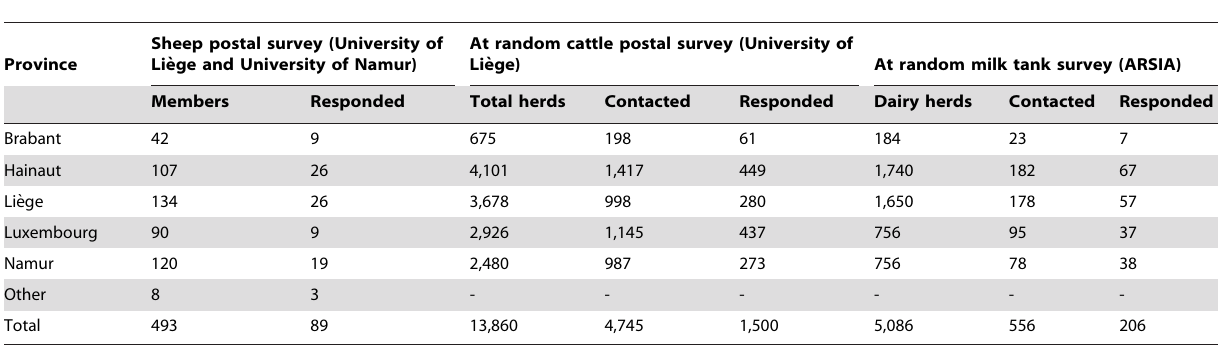
Table 1. Design of the retrospective surveys.